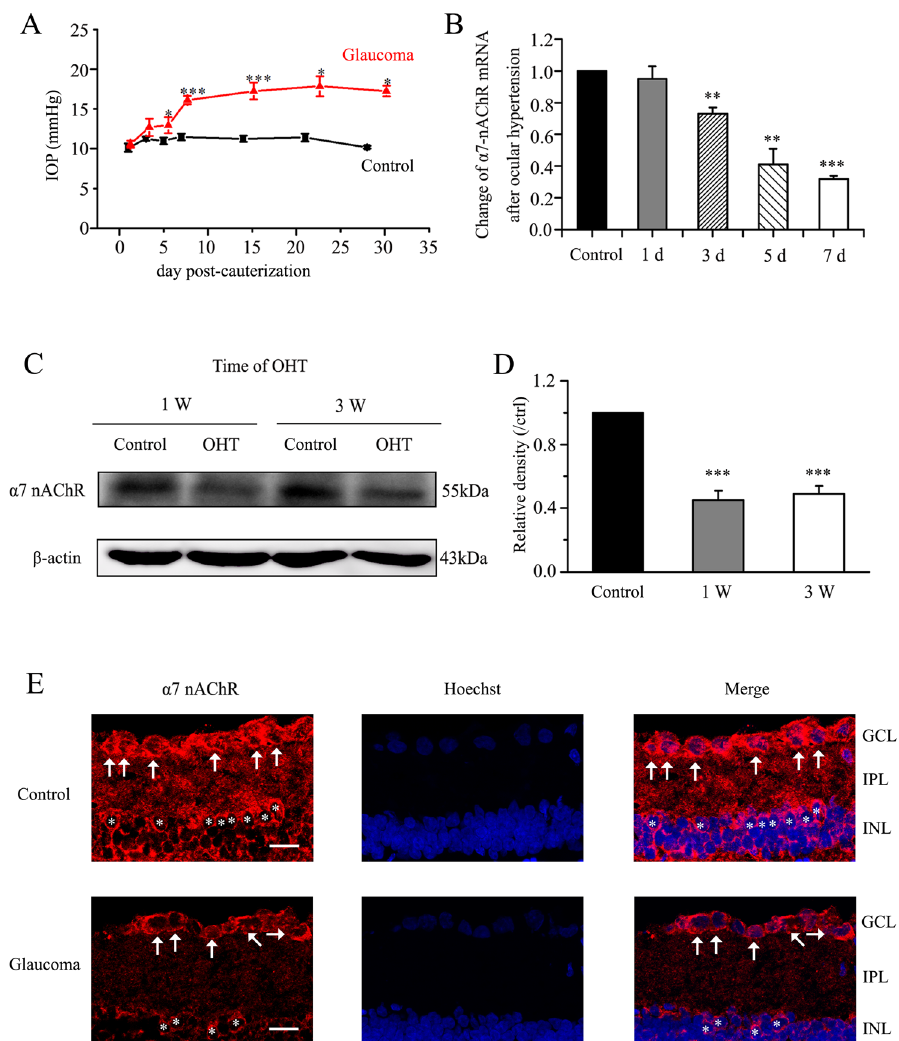
Figure 1. Chronic ocular hypertension downregulates α 7-nAChR expression in adult rat retina. ( A ) Changes in IOP after inducing ocular hypertension. The IOP is significantly greater in eyes that underwent EVC than in control eyes ( *** p < 0.001). ( B ) Real-time PCR analysis of α 7-nAChR mRNA expression in control and glaucomatous retinas at 1, 3, 5, and 7 days after EVC (1 day, n = 4; 3 days, n = 4; 5 days, n = 4; 7 days, n = 6); expression was normalized by the expression in the control retina. ** p < 0.01, *** p < 0.001 vs. control retina. ( C ) Representative western blot of α 7-nAChR expression in control and glaucomatous retinas. The expression of the 55 kDa protein decreases at 1 week after EVC and is sustained for up to 3 weeks. The full-length blots are presented in Supplementary Figure S1. ( D ) Densitometric analysis of α 7-nAChR expression at 1 week ( n = 6) and 3 weeks ( n = 8) after EVC. Expression was normalized to the expression in the control retina. *** p < 0.001 vs. control retina. ( E ) Micrographs of 10 μ m thick transverse sections of control and glaucomatous retinas. In contrast to the control retina (top panel), only a few ganglion cells are observed in the glaucomatous retina (bottom panel). Bar, 15 μ m. The results in A , B , and D are expressed as the mean ± SE. α 7-nAChR, α 7 nicotinic acetylcholine receptor; d, day; IOP, intraocular pressure; OHT, ocular hypertension; w, week; GCL, ganglion cell layer; INL, inner nuclear layer; IPL, inner plexiform layer. The arrows indicate RGCs; the asterisks indicate amacrine